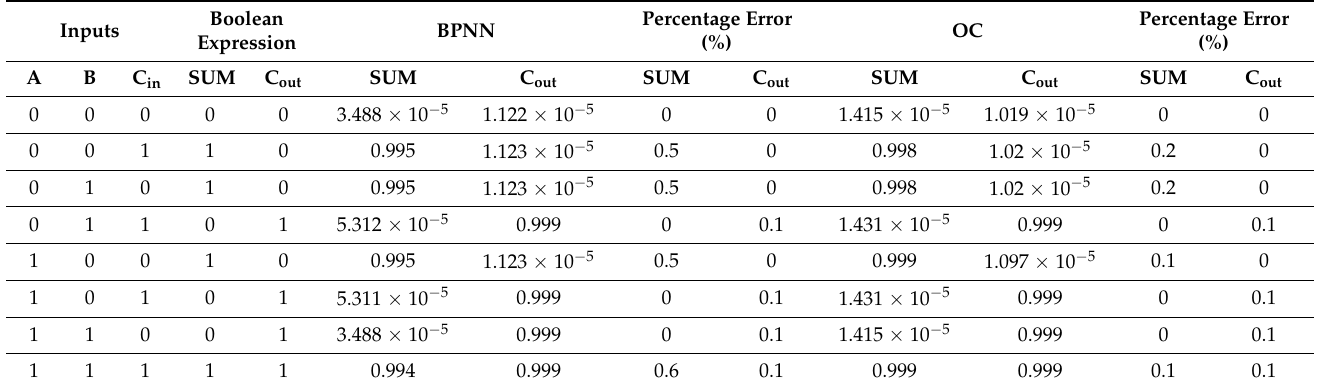
Table 3. Comparison results of FA